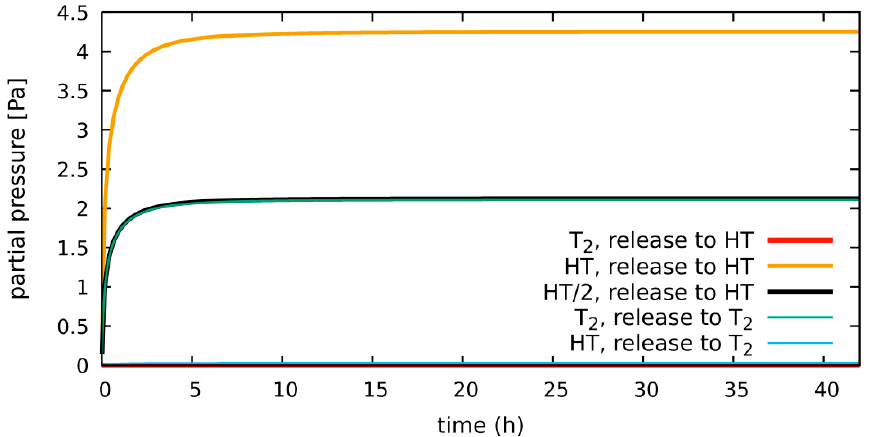
Figure 20. T 2 and HT partial pressures at the purge gas outlet for T 2 vs. HT release from pebbles.